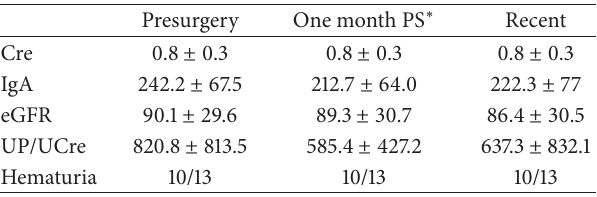
Table 1: Baseline characteristic of 13 patients with IgA nephropathy. Table 2: Overall examined data.